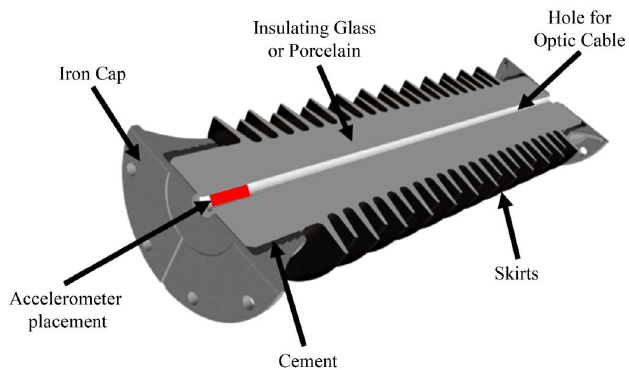
Fig. 1. Turn section of insulator C30-850-II with hole for optic